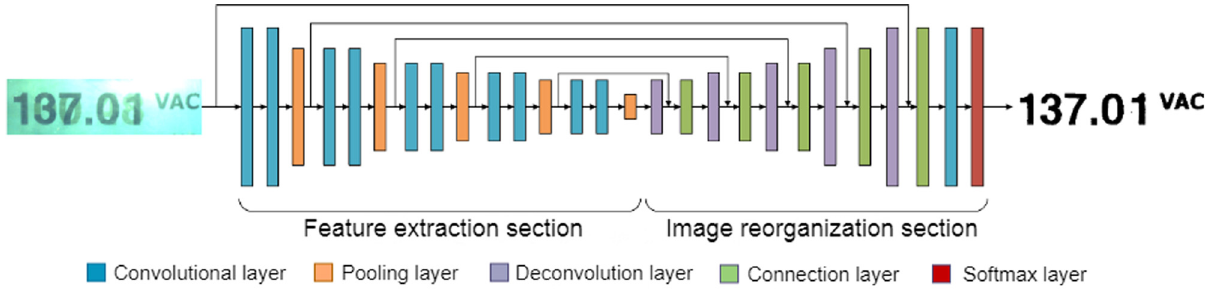
Figure 4: The structure of a fully convolutional neural